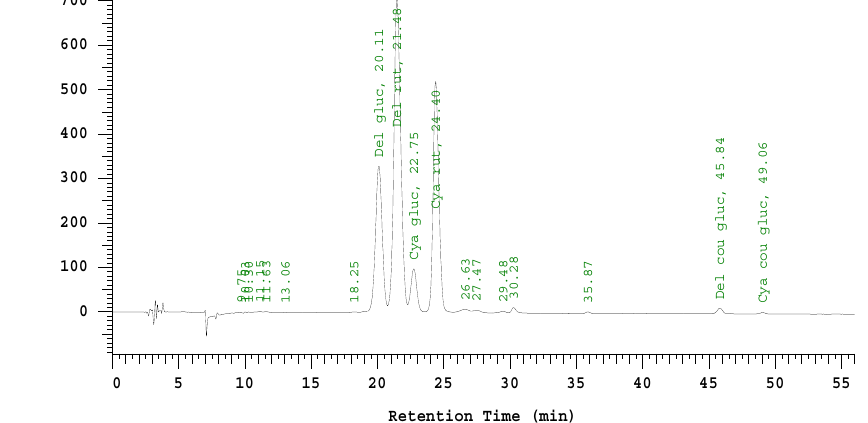
Figure 4. HPLC chromatogram (520 nm) of 1% HCl methanol-extracted anthocyanins from lyophilized ground black currant fruit.